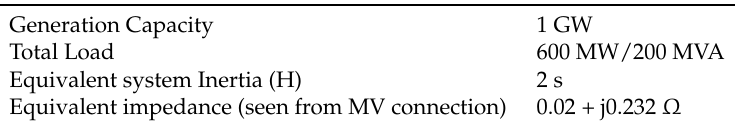
Table 1. Main power system: main